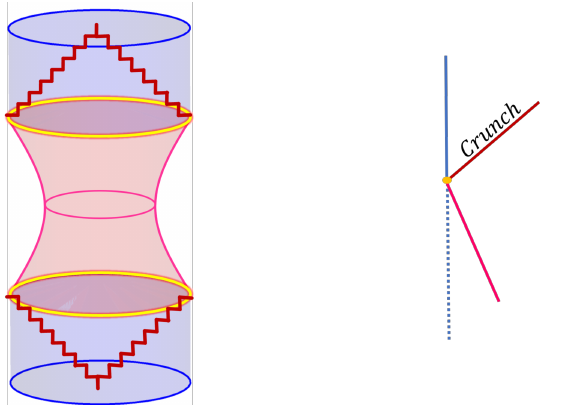
Figure 12 . A possible dS/CFT setup via braneworlds. Left: bulk viewpoint. A bulk AdS d +1 cylinder (in blue) has a holographic CFT d dual living at the boundary. The dS d braneworld, with cutoff surfaces in magenta, lives inside AdS d +1 . One might envisage dualizing the dS d gravity with a Euclidean CFT d − 1 living at I − and I + of the de Sitter hyperboloid (yellow). Bulk quantum corrections are expected to drive the braneworld model to incur big bang and big crunch-like singularities (red), replacing the upper and lower Lorentzian cylinders. Alternatively, one could avoid the singularities altogether by preparing the ‘in’ and ‘out’ states on I − and I + via a Euclidean path integral with suitable sources turned on. This would entail replacing the cylinders by appropriate Euclidean submanifolds, closing the contour of the path integral à la Schwinger-Keldysh [73–75]. Right: the dual quantum mechanical picture, with time running